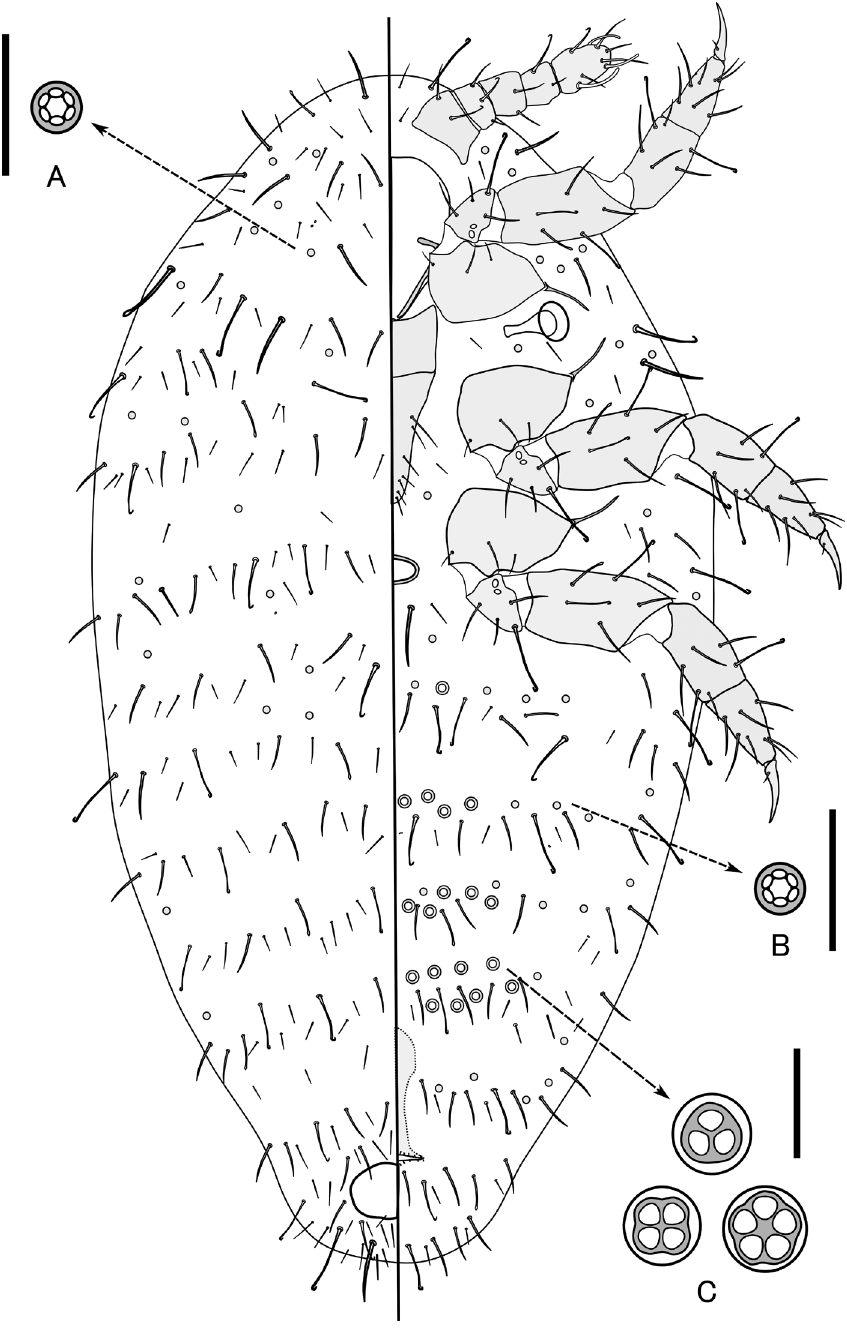
Figure 3. Ishigakicoccus shimadai Tanaka, sp. n. adult female. A Small multilocular pore on dorsal surface B Small multilocular pore on ventral surface C 3–5 locular pores on medial area of venter. Scale bars: 10